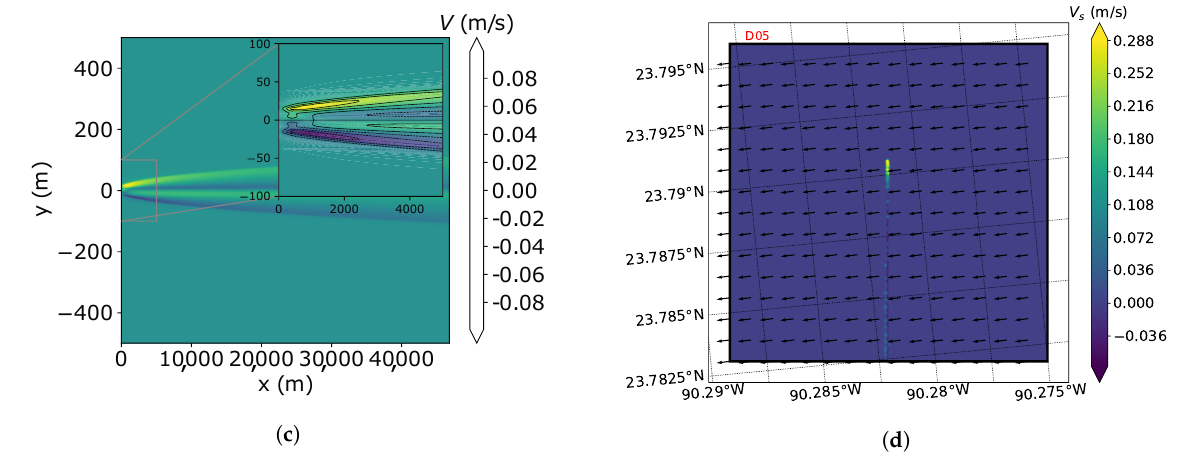
Figure 5. ( a ) U -component of surface currents predicted by the OpenFOAM model, ( b ) V -component of surface currents predicted by the OpenFOAM model, ( c ) U -component of surface currents mapped onto WRF domain, and ( d ) V -component of surface currents mapped onto WRF domain. The black arrows indicate the direction of the wind at 10 m elevation. Table 5. The Yonsel University Planetary Boundary Layer scheme (YSU PBL) is used for mesoscale simulations [20]. Simulation